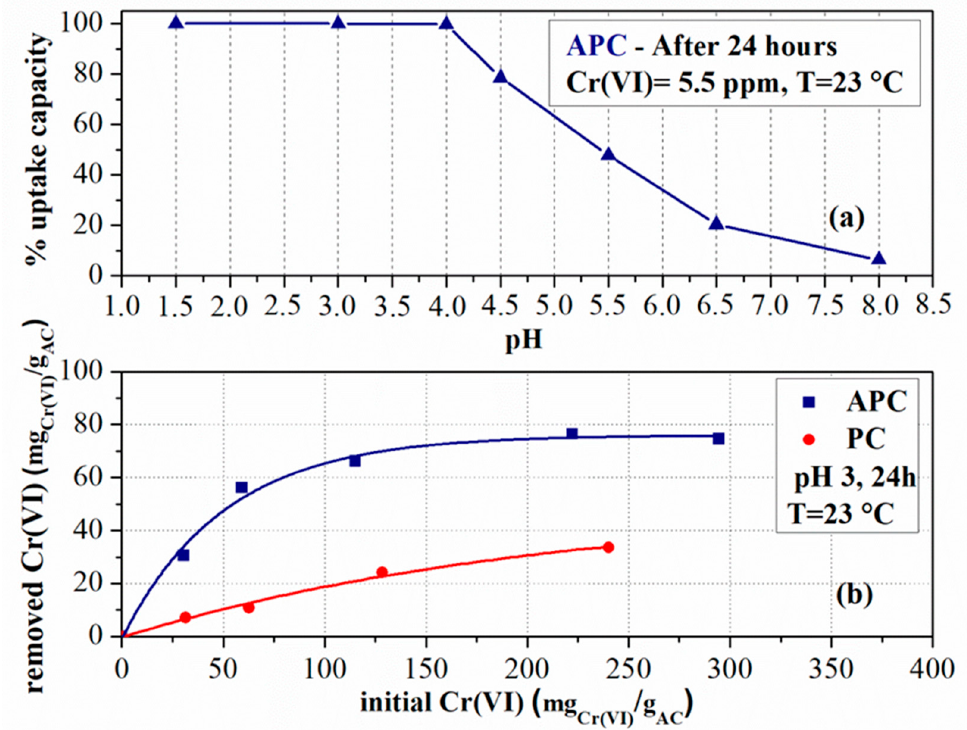
Figure 10. ( a ) Effect of pH on maximum uptake capacity for APC. ( b ) Effect of initial Cr(VI) concen- tration on Cr(VI) removed amount for pH = 3 and T = 23 ◦ C after 24 h by PC and